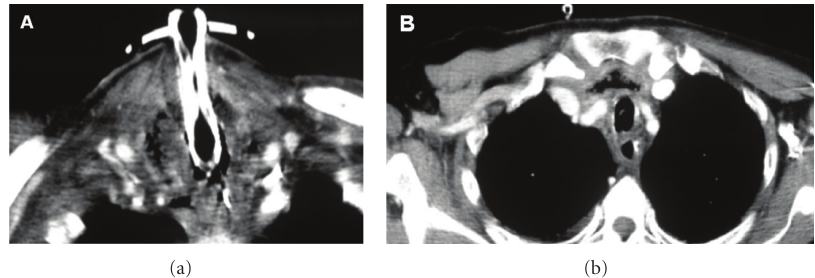
Figure 3: Patient number 2—CT images. (a) Pools of liquid/gaseous material in the neck planes, around the trachea, can be seen. (b) Mild expansion of the upper mediastinum can be observed. A large pool of liquid and gaseous material is easily visible in the retrosternal area.